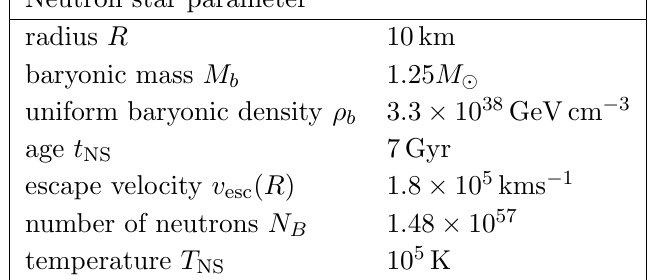
Table 1 . The parameters of the benchmark neutron stars used in our numerical estimates. These parameter choices are representative of the recently observed neutron star binary merger